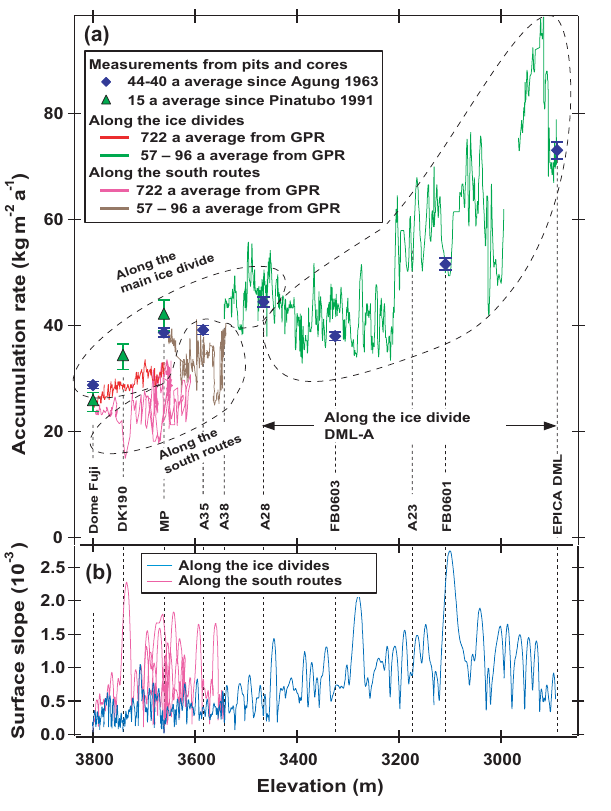
Fig. 9. Annual accumulation rate for the 40-km-long cross-ice di- vide survey at MP. (a) Annual accumulation rates averaged over 7.9ka (red trace) and 722a (blue trace) are determined from sub- surface radar data. They are compared with the average over 44 a at MP. Also shown are (b) surface elevation, (c) surface slope, and (d) bed elevation. Decrease in accumulation rate from the north- ern coastal side of the ice divide toward the southern interior side. The annual accumulation rate is locally higher at locations with flat or concave surface topography, as indicated by thin vertical dashed lines. Similarly, the annual accumulation rate is locally lower at locations with steep surfaces or a convex surface